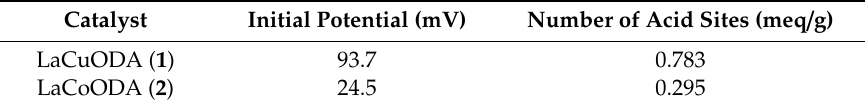
Table 1. Determination of acid strength and number of acid sites for LaM(ODA).